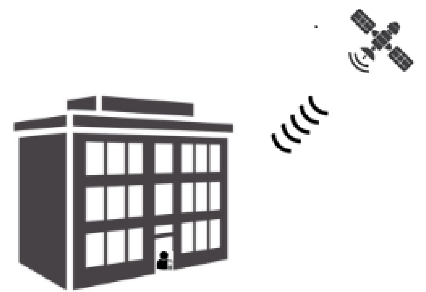
Figure 3. GPS sensors can receive signals when the receiver is close to an external door.